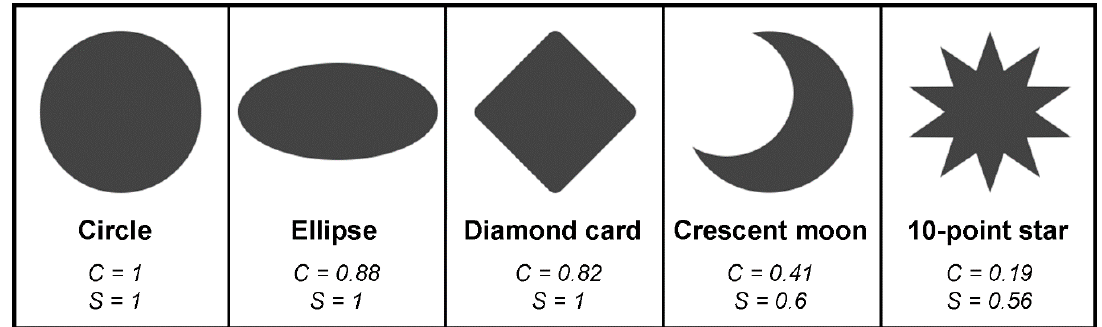
Figure 2. Image showing various shapes (circle, ellipse, diamond card, crescent moon, 10-point star) and their respective circularity ( C ) and solidity ( S ) values.